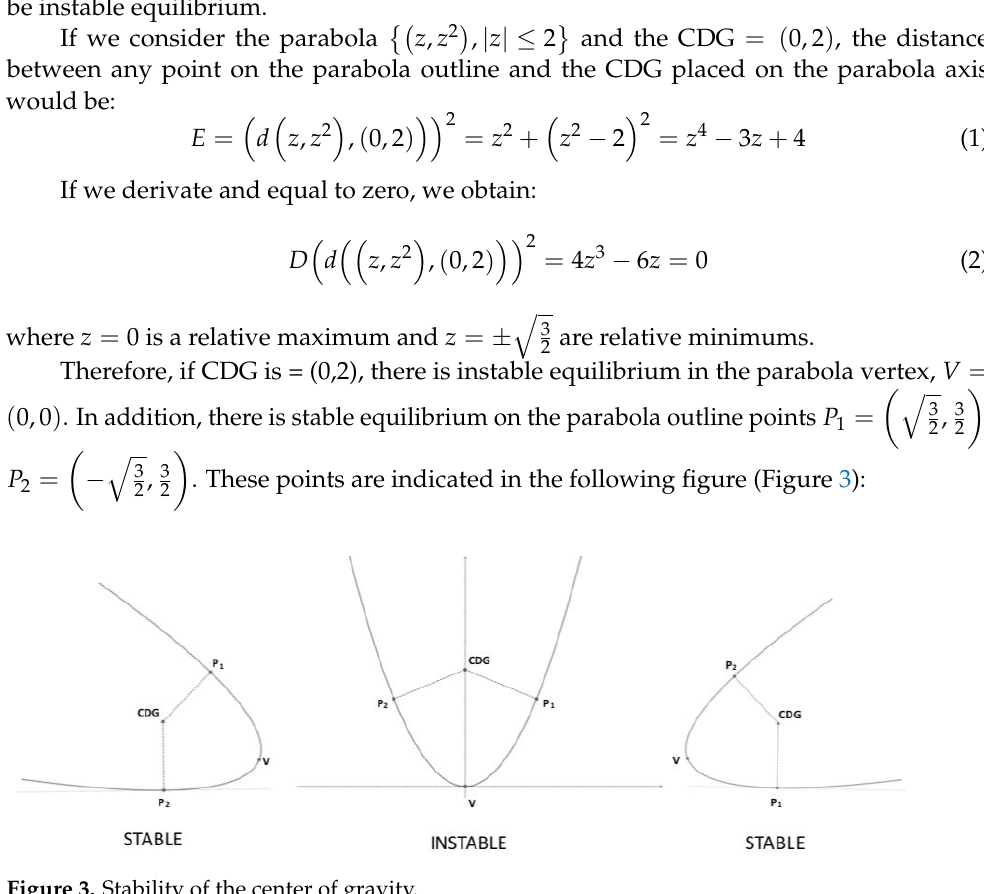
Figure 3. Stability of the center of gravity.